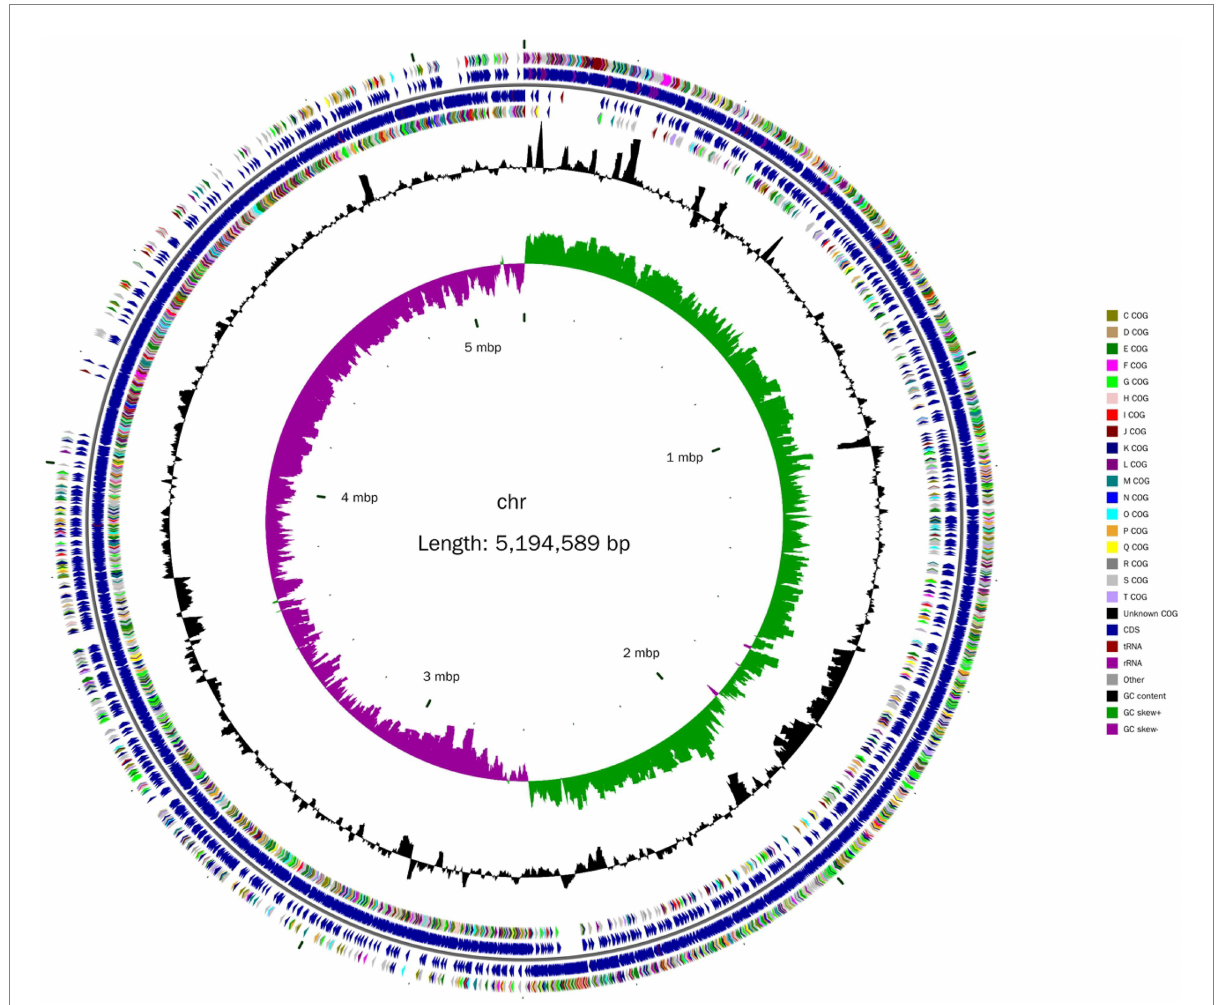
FIGURE 1 Circular chromosome diagram of B. aryabhattai LAD. From the inner circle to the outer circle, the information on each of the seven circles shows genome position, GC skew, GC content, coding sequence on the positive and strands (classified by Cluster of Orthologous Groups of protein), and the position of the coding sequence, tRNA and rRNA on the